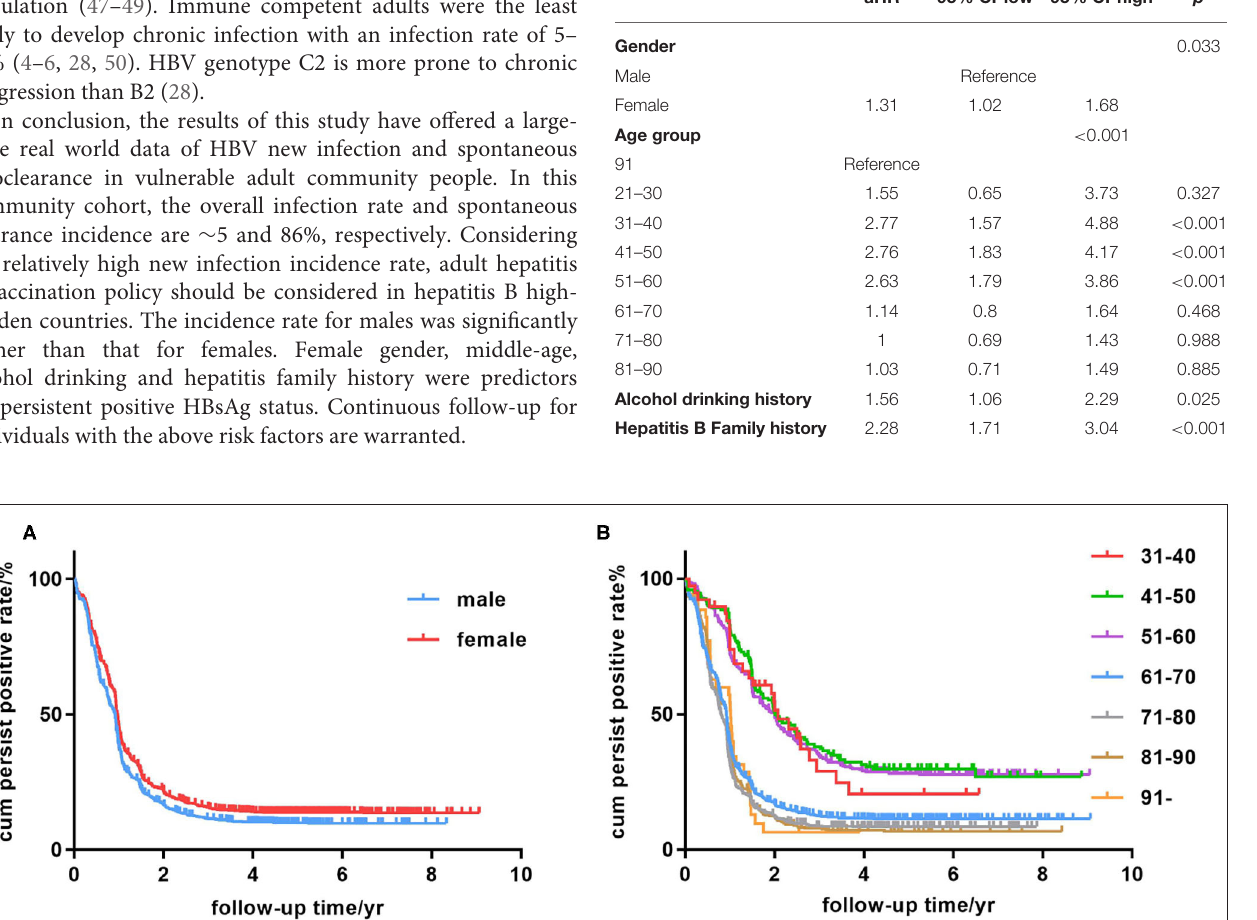
Frontiers in Medicine |